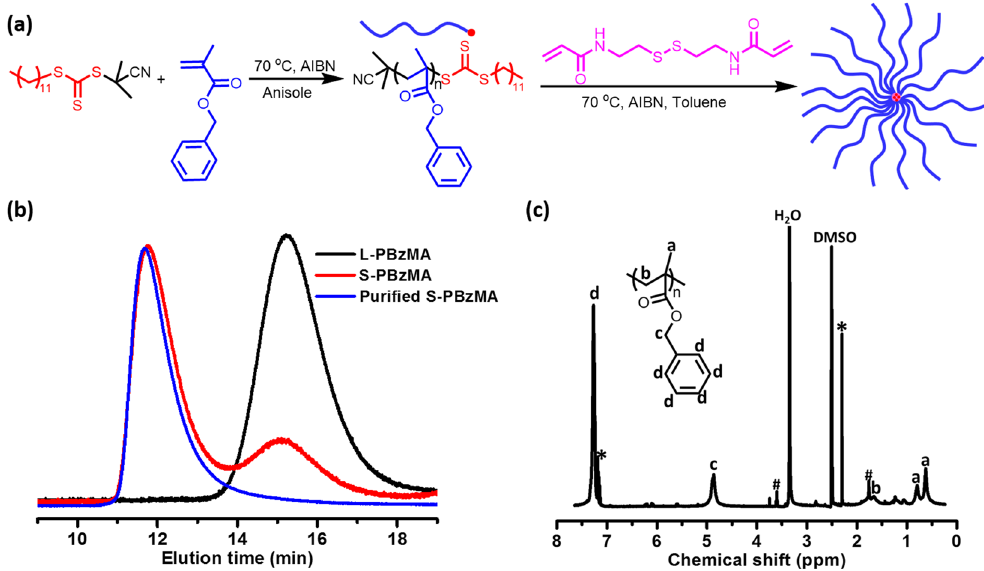
Figure 1. Synthesis of PBzMA CCS polymer. ( a ) The schematic diagram of the synthesis steps. ( b ) GPC trace confirming the formation of the CCS polymer. ( c ) 1 H NMR spectra of the CCS polymer (recorded in DMSO- d 6